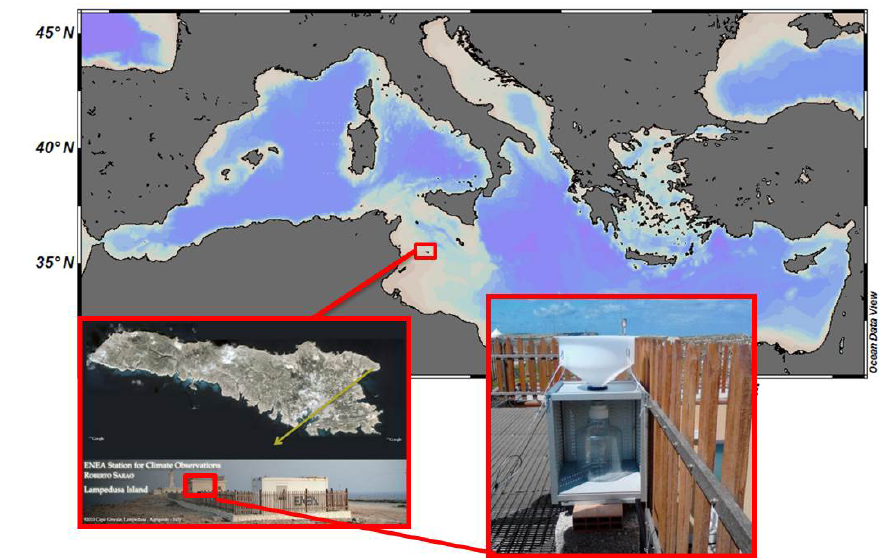
Figure 1. Sampling location (Lampedusa; 35.5 ◦ N, 12.6 ◦ E) and the total atmospheric deposition